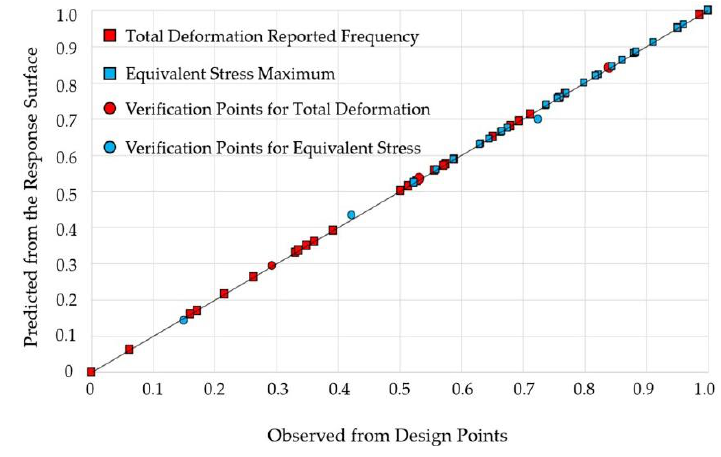
Figure 8. The fitting curve of the test results.